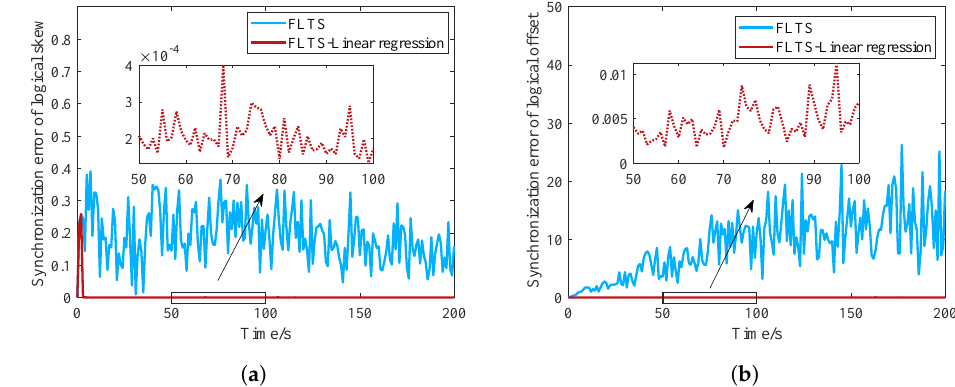
Figure 8. Convergence comparison of the logical clock against communication delay. ( a ) Logical clock skew; ( b ) Logical clock